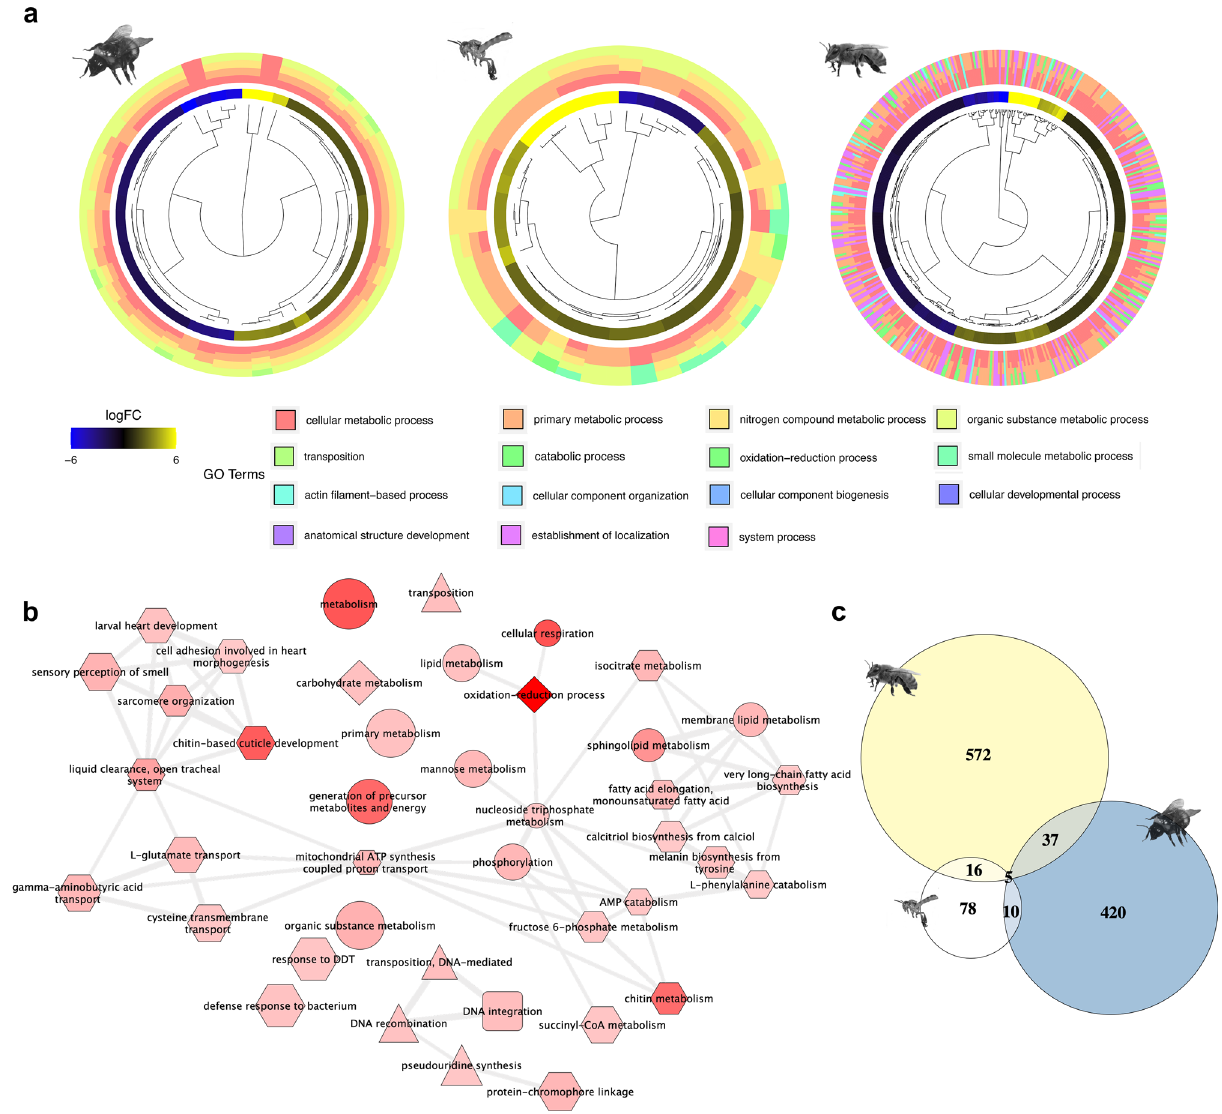
Figure 4. Comparisons among B. terrestris , T. angustula and A. mellifera head GO processes involved in task specialization. a— Hierarchical clustering of the differentially expressed transcripts using the third hierarchical level of GO annotation organized by their mean logFC difference between nurses and foragers. Outer circle colors indicate which GO term the gene could be associated. b —Similarity network of the enriched GO terms in all species, after semantic similarity-based reduction. GO terms that are more similar to each other are linked, and the line width indicates the degree of similarity. Edge shape indicates whether the shown term is enriched in A. mellifera (hexagon), in B. terrestris (triangle), in T. angustula (circle), commonly enriched in B. terrestris and T. angustula (square), or commonly enriched in A. mellifera and T. angustula (diamond). Edge color intensity indicates the p value in the enrichment test (the darker the color tone, the smaller the p value). Edge size indicates the frequency of the GO term in the entire UniProt database. c —Euler diagram showing the number of genes in common between the set of differentially expressed genes of each species. A. mellifera by A. Wide, T. angustula by L. Costa—images reproduced with permission from the original